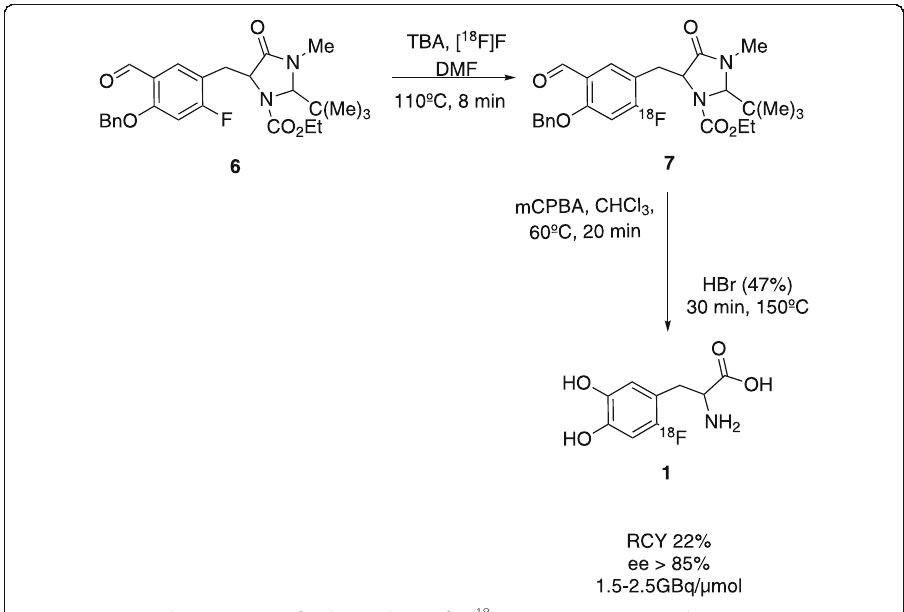
Fig. 3 Isotopic Exchange reaction for the synthesis of 6-[ 18 F]FDOPA 1 (Wagner et al.,